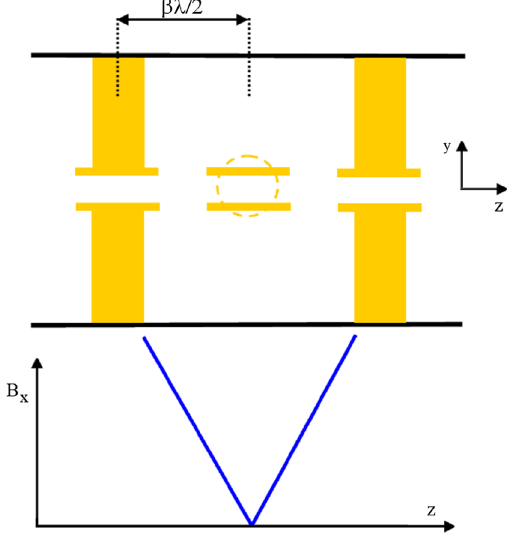
FIG. 12. Linear dependence of the magnetic field between the